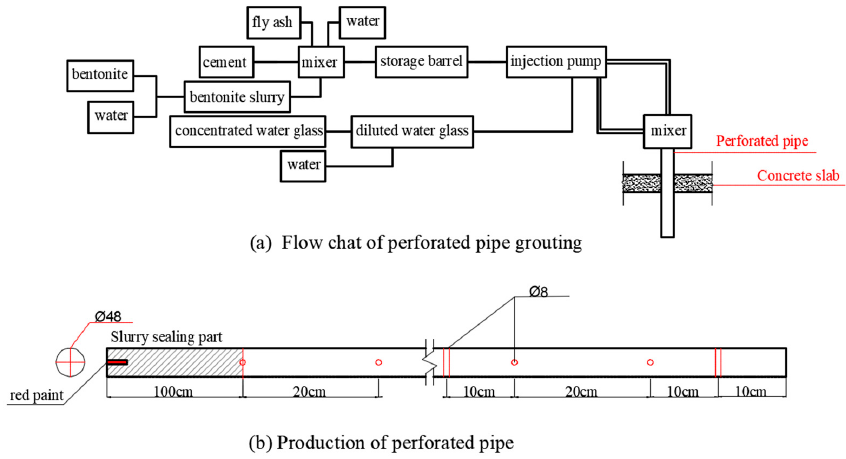
Figure 3. Flow chart of perforated pipe grouting and production of perforated pipe.